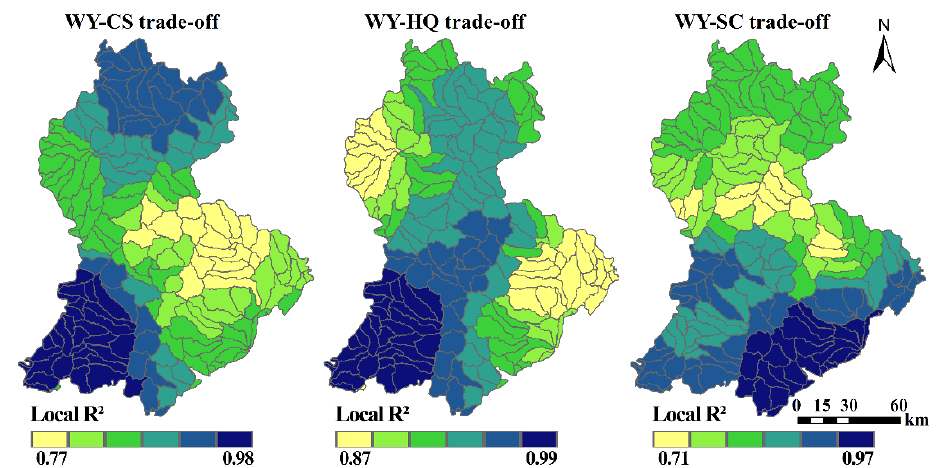
Figure 6. Spatial patterns of local R 2 from GWR between ES trade-offs and influencing factors. Ab- breviations: CS: carbon storage; WY: water yield; SC: soil conservation; HQ: habitat quality.